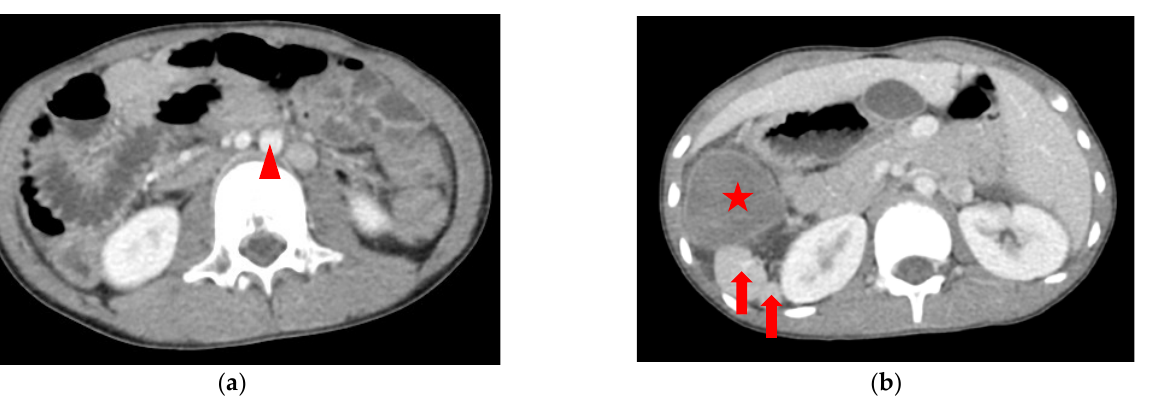
Figure 2. Plain film of the chest and abdomen: ( a ) right-sided stomach gas (arrow head) and levo- cardia; ( b ) midline liver shadow and colon gas on the left side (arrows), suggesting heterotaxy syn- drome and malrotation. Contrast medium that had not finished metabolism was retained in the urinary bladder.